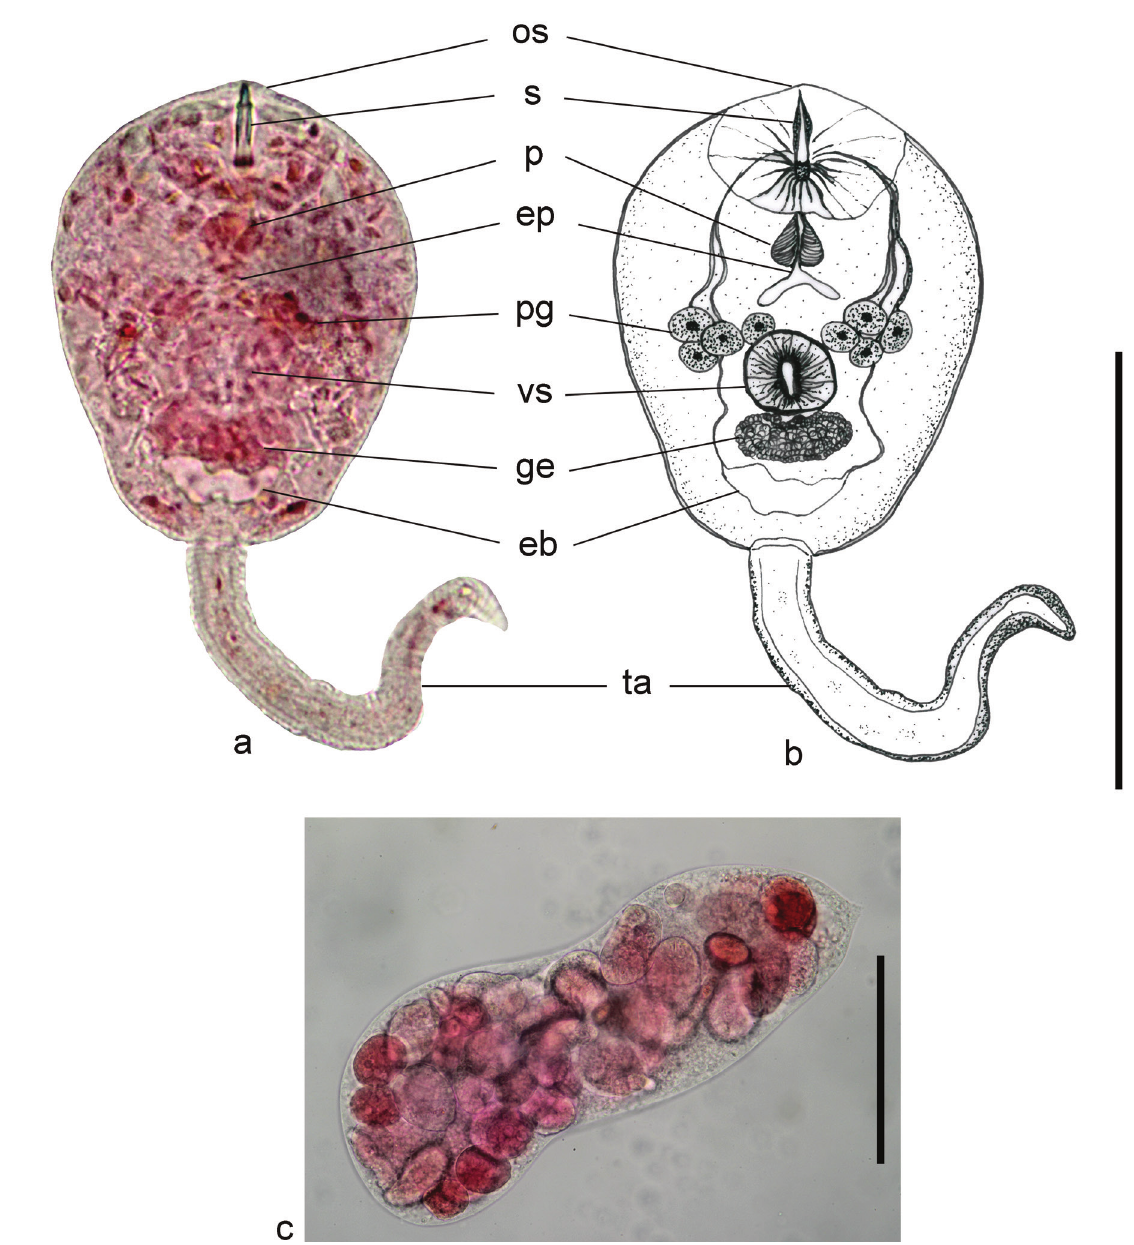
Figure 7. Maritreminoides obstipus (Van Cleave & Müller, 1932). a . specimen stained with 0.5% neutral red. b . drawing of cercaria. c . sporocyst stained with 0.5% neutral red. Abbreviations – eb: excretory bladder; ep: esophagus; ge: genital primordium; os: oral sucker; p: pharynx; pg: penetration gland; s: stylet; ta: tail; vs: ventral sucker. Scale bars: 50